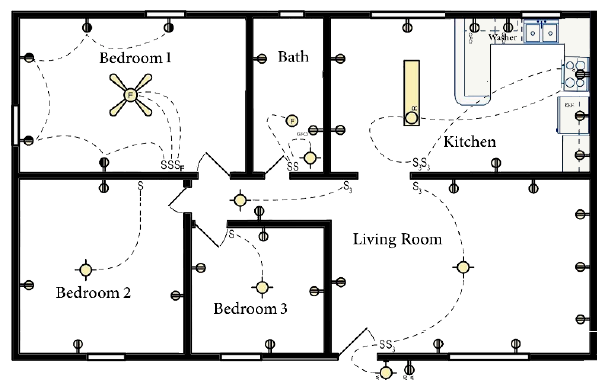
Figure 7. 2D plan of the single-family house.